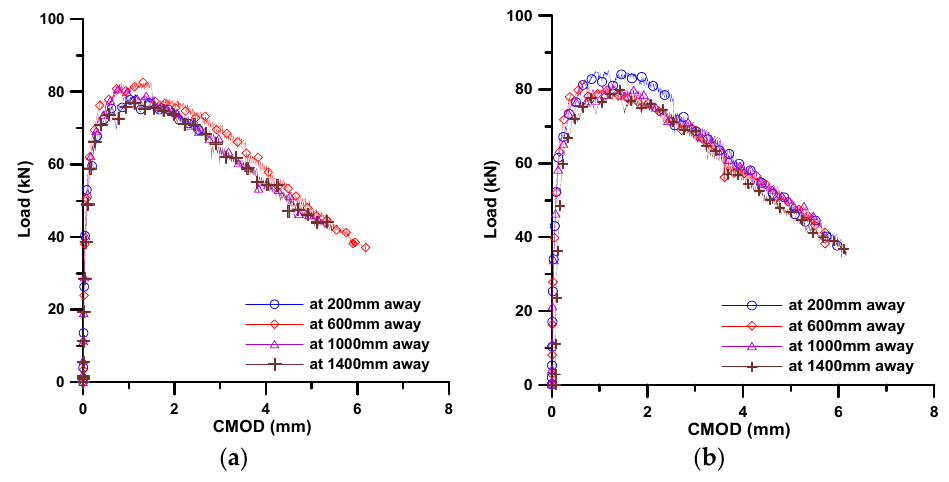
Figure 7. Load-CMOD curves obtained from experiments; ( a ) from beam 1; and ( b ) from beam 2.